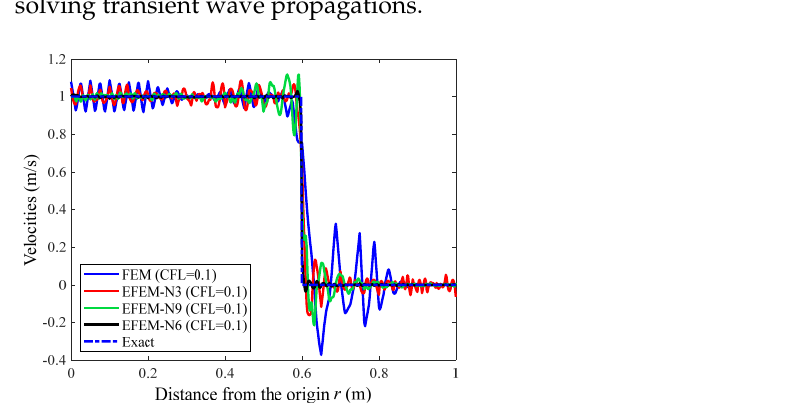
Figure 4. The calculated velocity distributions of this elastic bar from various numerical approaches when the time point t = 0.6 s.